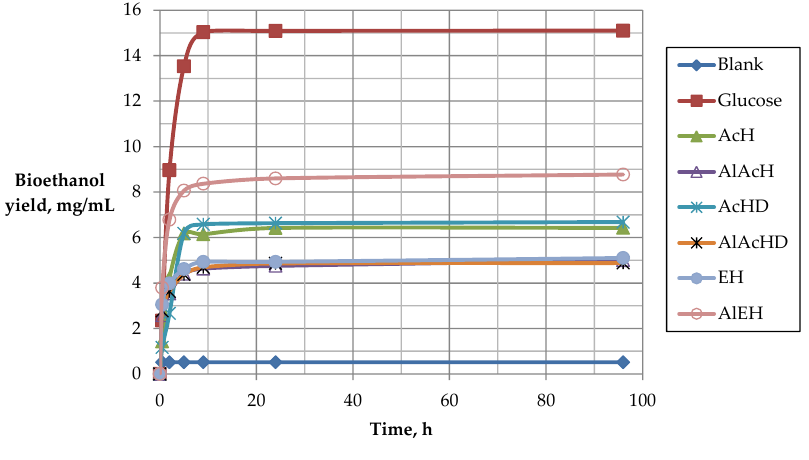
Figure 10. Courses of performed fermentations.